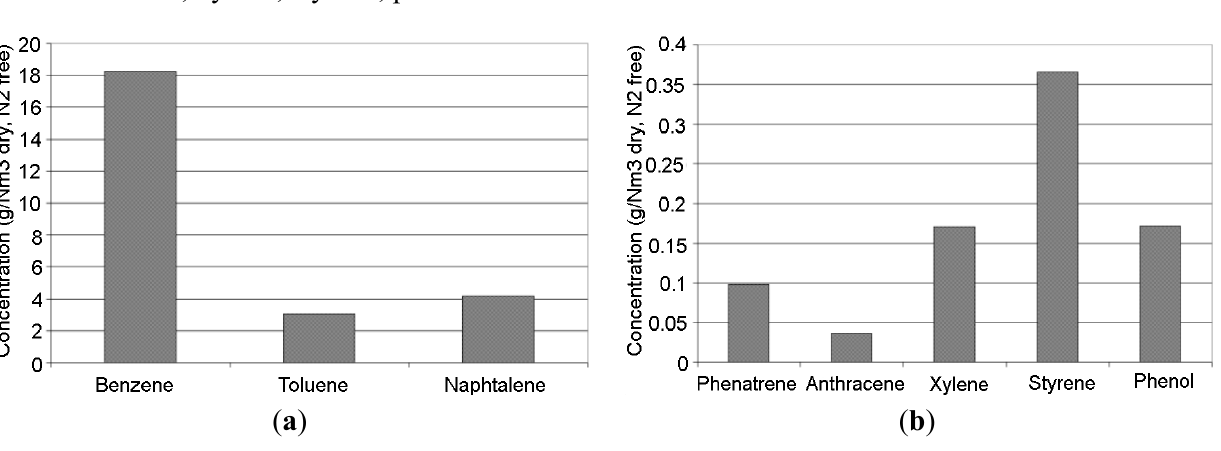
Figure 2. Reference TAR concentration in the gas obtained from steam gasification of biomass at 850 °C (dry, N free): ( a ) benzene, toluene, naphthalene; ( b ) phenanthrene, 2 anthracene, xylene, styrene,